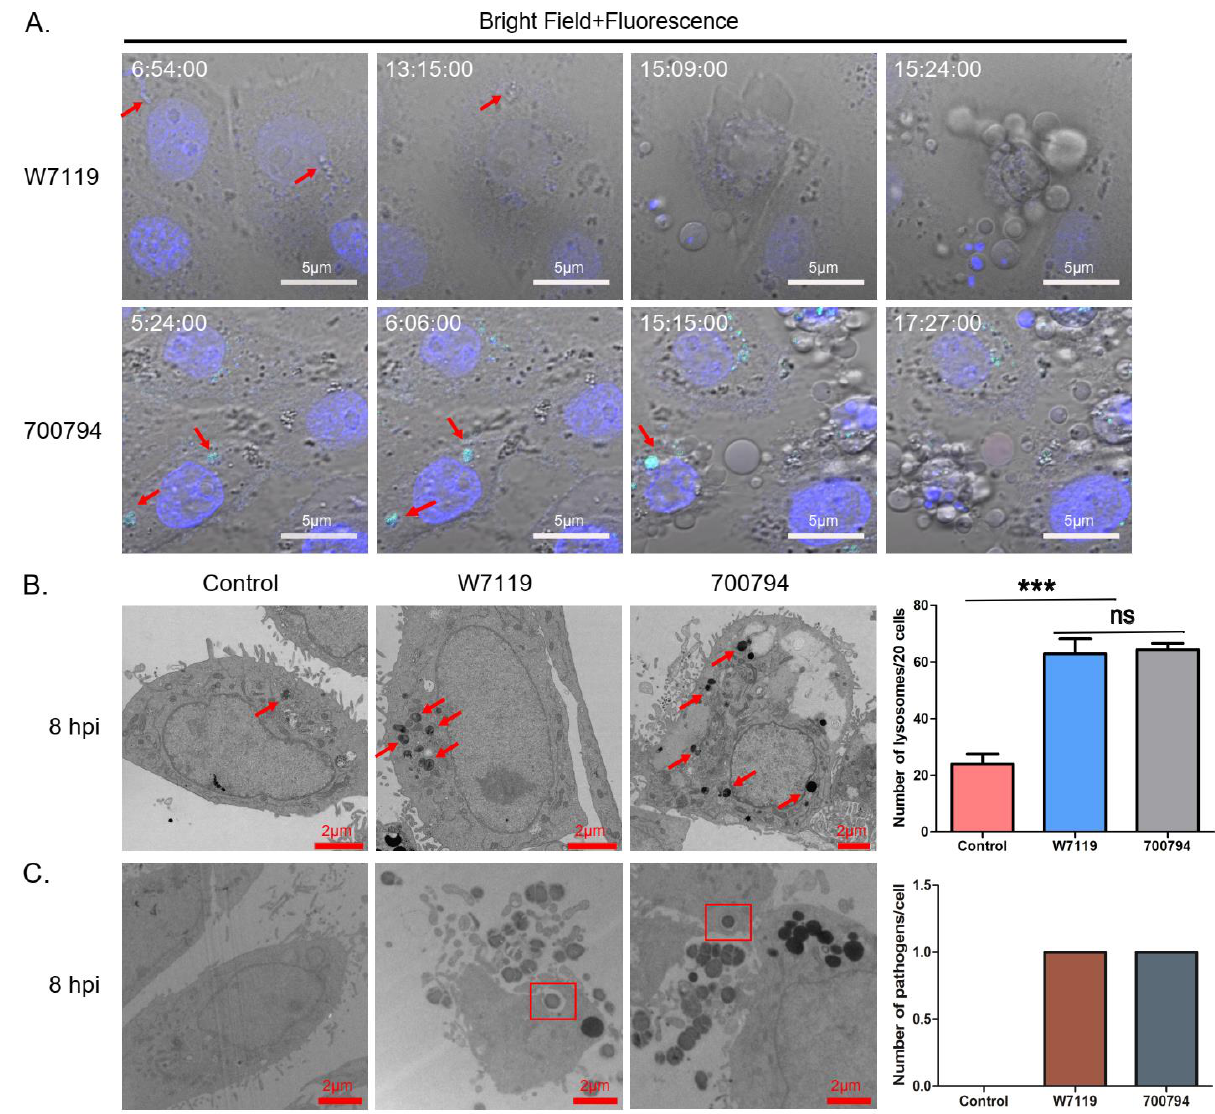
Figure 5. Tracking the phagocytosis of PAM-Tang cells. ( A ) Live-cell imaging of phagocytosis by PAM-Tang cells after infection with fluorescent-labeled (green) S. suis vir-700794 or unlabeled S. suis avir-W7119 (MOI = 1). The red arrows indicate S. suis cells, and numbers at upper left indicate infection time (h:min:sec); cell nuclei (blue) were stained with Hoechst 33342. ( B ) Electron micrographs of macrophages showing a significant increase in number of lysosomes (red arrows) in cells at 8 h post-infection (hpi) by S. suis. ( C ) Electron micrographs of phagocytic vacuole (red rectangle) in PAM-Tang at 8 h post-infection (hpi) by S. suis. Experiments were repeated three times, results are expressed as means ± S.D, significance was determined using one-way ANOVA multiple-comparison test; ***: p < 0.001; ns: not